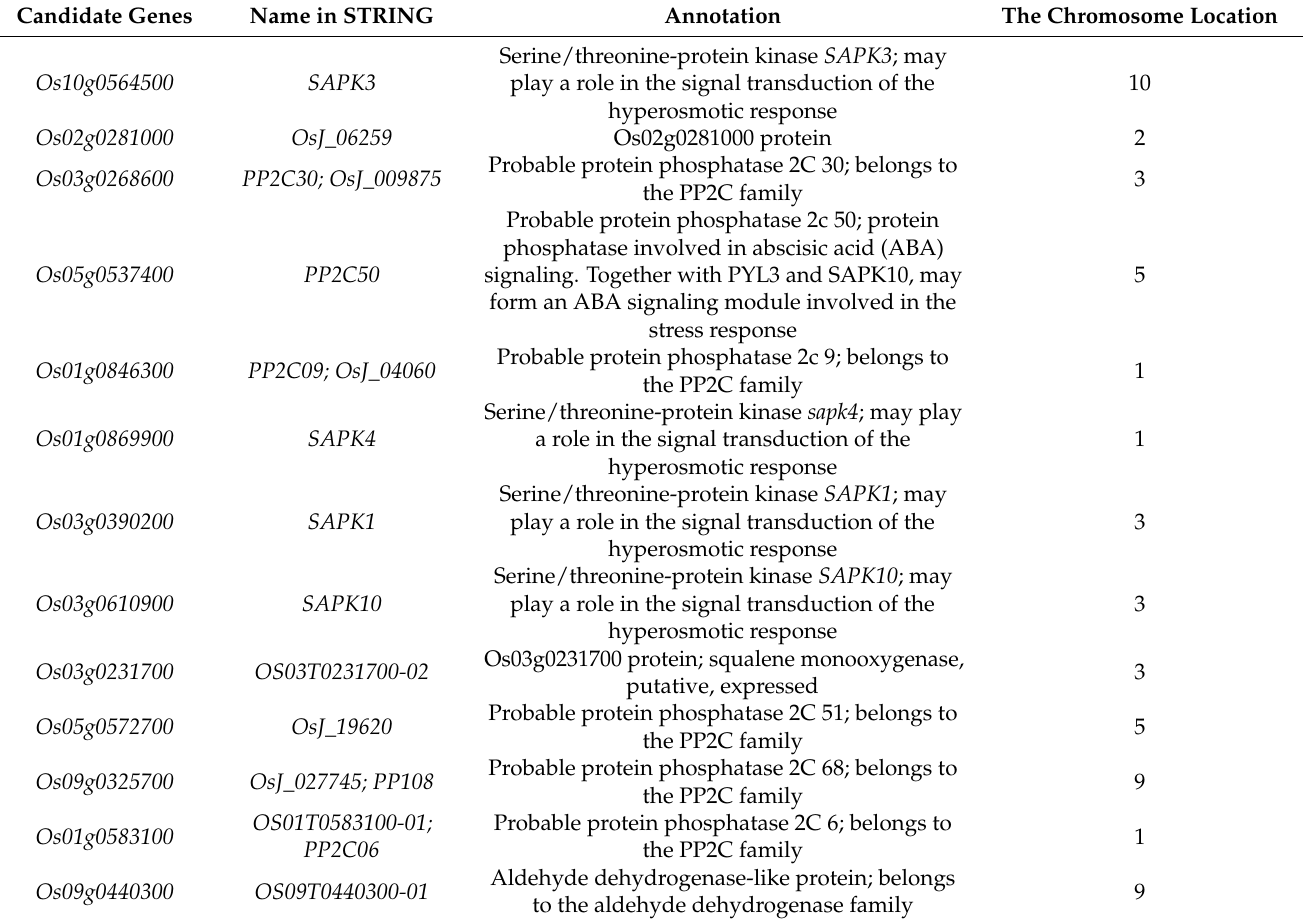
Figure 4. The interaction network between the potential genes and the known drought stress genes. The purple, orange, and light green nodes represent the known drought stress genes, the candidate genes, and other potential genes except the candidate genes, respectively. Each green line represents the interaction between a potential gene and a known drought stress gene. Table 2. Annotation of candidate genes related to drought